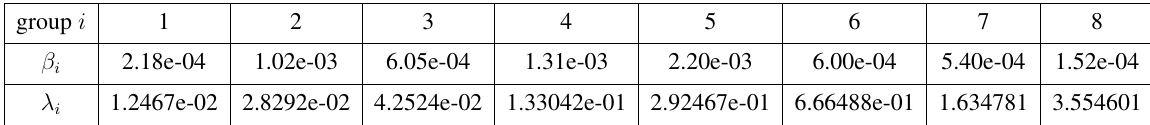
Table 2: Eight-group, delayed-neutron precursor